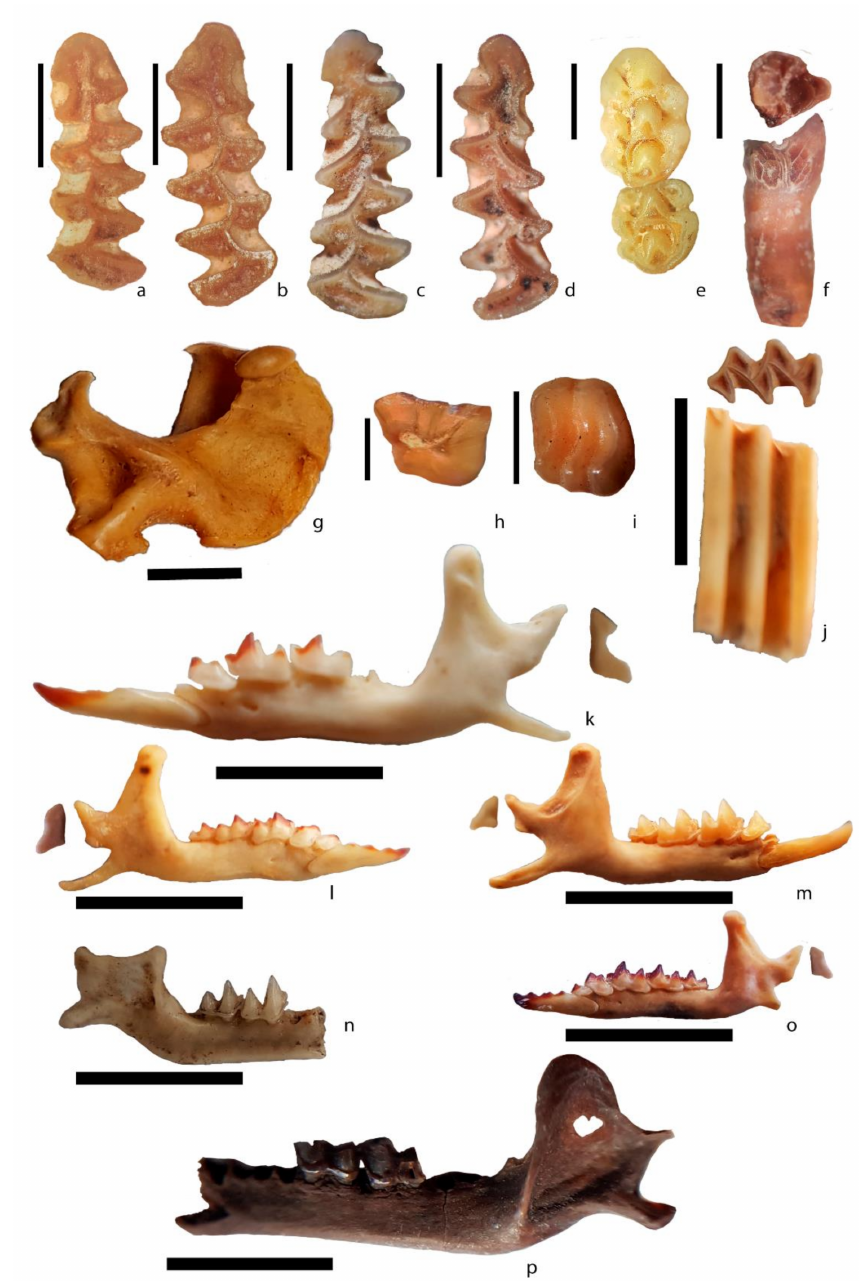
Figure 4. Diagnostic elements of the different taxa present at El Portal ó n de Cueva Mayor Early Chalcolithic funerary context: ( a ) Microtus arvalis , left m1 (occlusal view); ( b ) M. agrestis , right m1 (occlusal view); ( c ) M. ( Terricola ) duodecimcostatus , left m1 (occlusal view); ( d ) M. ( T. ) lusitanicus , right m1 (occlusal view); ( e ) Apodemus gr. sylvaticus-flavicollis , right M1- M2 (occlusal view); ( f ) Sciurus vulgaris , left p4 (occlusal and lingual views); ( g ) Talpa sp., left humerus (posterior view); ( h ) Oryctolagus cuniculus , right I1 (occlusal view); ( i ) Eliomys quercinus , left m1 or m2 (occlusal view); ( j ) Arvicola sapidus , left M1 (occlusal and buccal views); ( k ) Neomys fodiens , left mandible with i1-p4-m1-m2 (lateral view) and condyle detail (posteroventral view); ( l ) Sorex gr. araneus-coronatus right mandible with i1-a1-p4-m1-m2-m3 (lateral view) and condyle detail (posteroventral view); ( m ) Crocidura suaveolens , right mandible with i1-p4-m1-m2-m3 (lateral view) and condyle detail (posteroventral view); ( n ) Miniopterus schreibersii , right mandible with m2-m3 (lateral view); ( o ) Sorex minutus , left mandible with i1-a1-p4-m1-m2-m3 (lateral view) and condyle detail (posteroventral view); ( p ) Myotis gr. myotis-blythii left mandible with m1-m2 (lateral view). Scale bars of a–f, h, i = 1 mm; g, j–p = 5